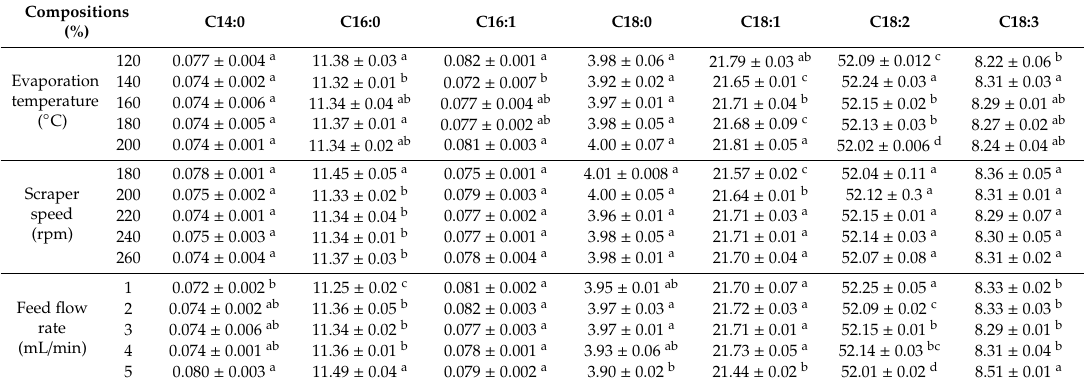
Table 3. E ff ect of molecular distillation parameters on the fatty acid contents of EAE-produced soybean